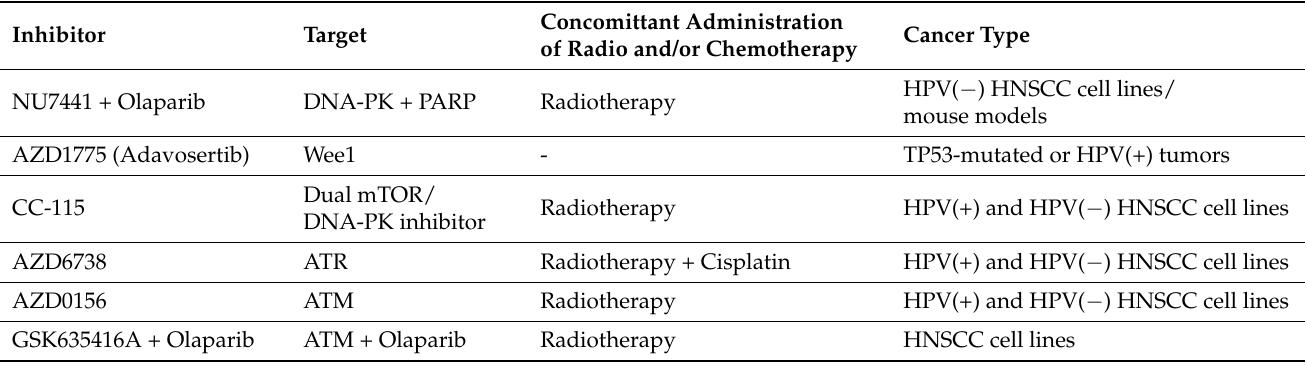
Table 3. List of DDR inhibitors currently being investigated